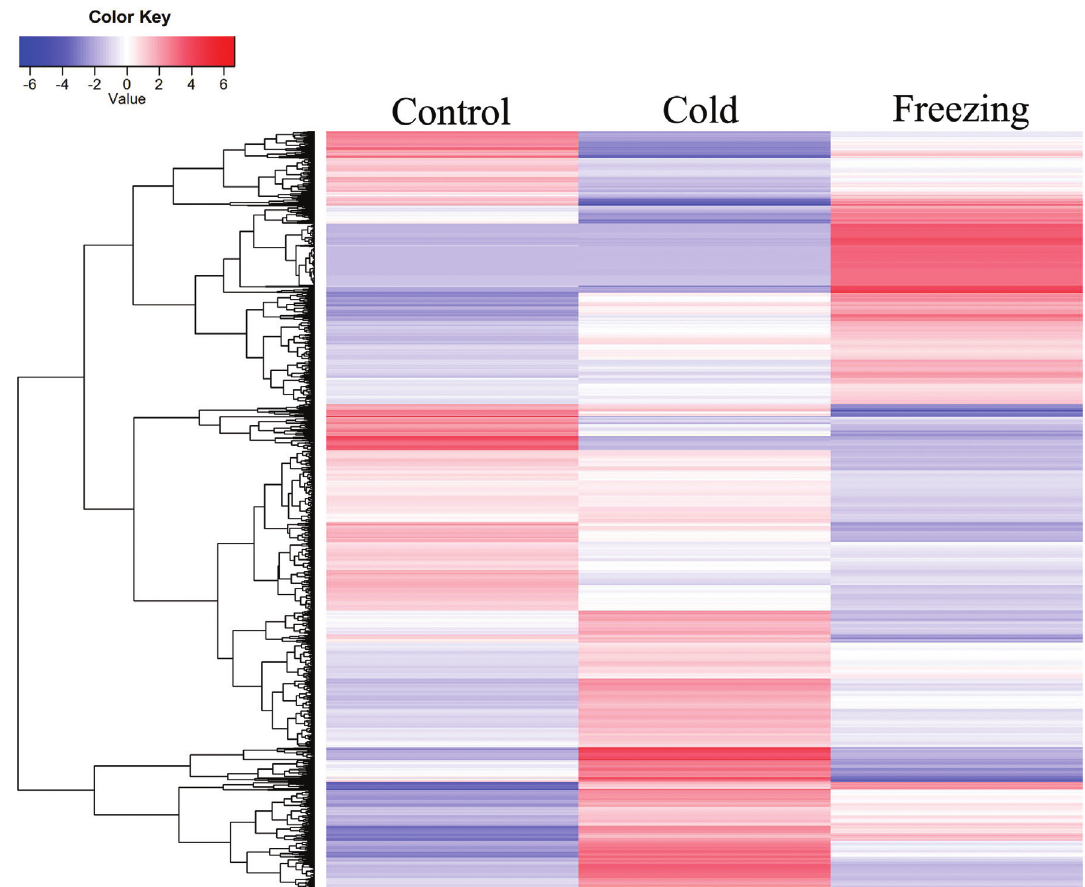
Figure 4 - Heatmap showing expression profiles of differentially expressed transcripts in response to cold and/or freezing